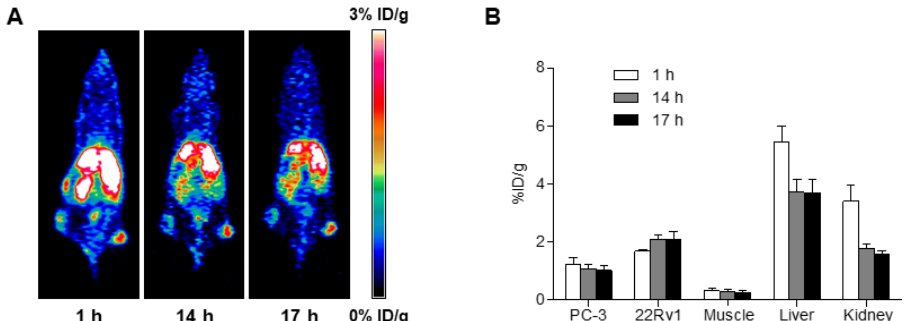
Figure 4. ( A ) MicroPET images of mice inoculated with PC3 (left flank) and 22Rv1 (right flank) cells and ( B ) the ROI analysis of major tissues. The mice were injected with [ 64 Cu] 3B and PET images were acquired at 1, 14, and 17 h after injection.